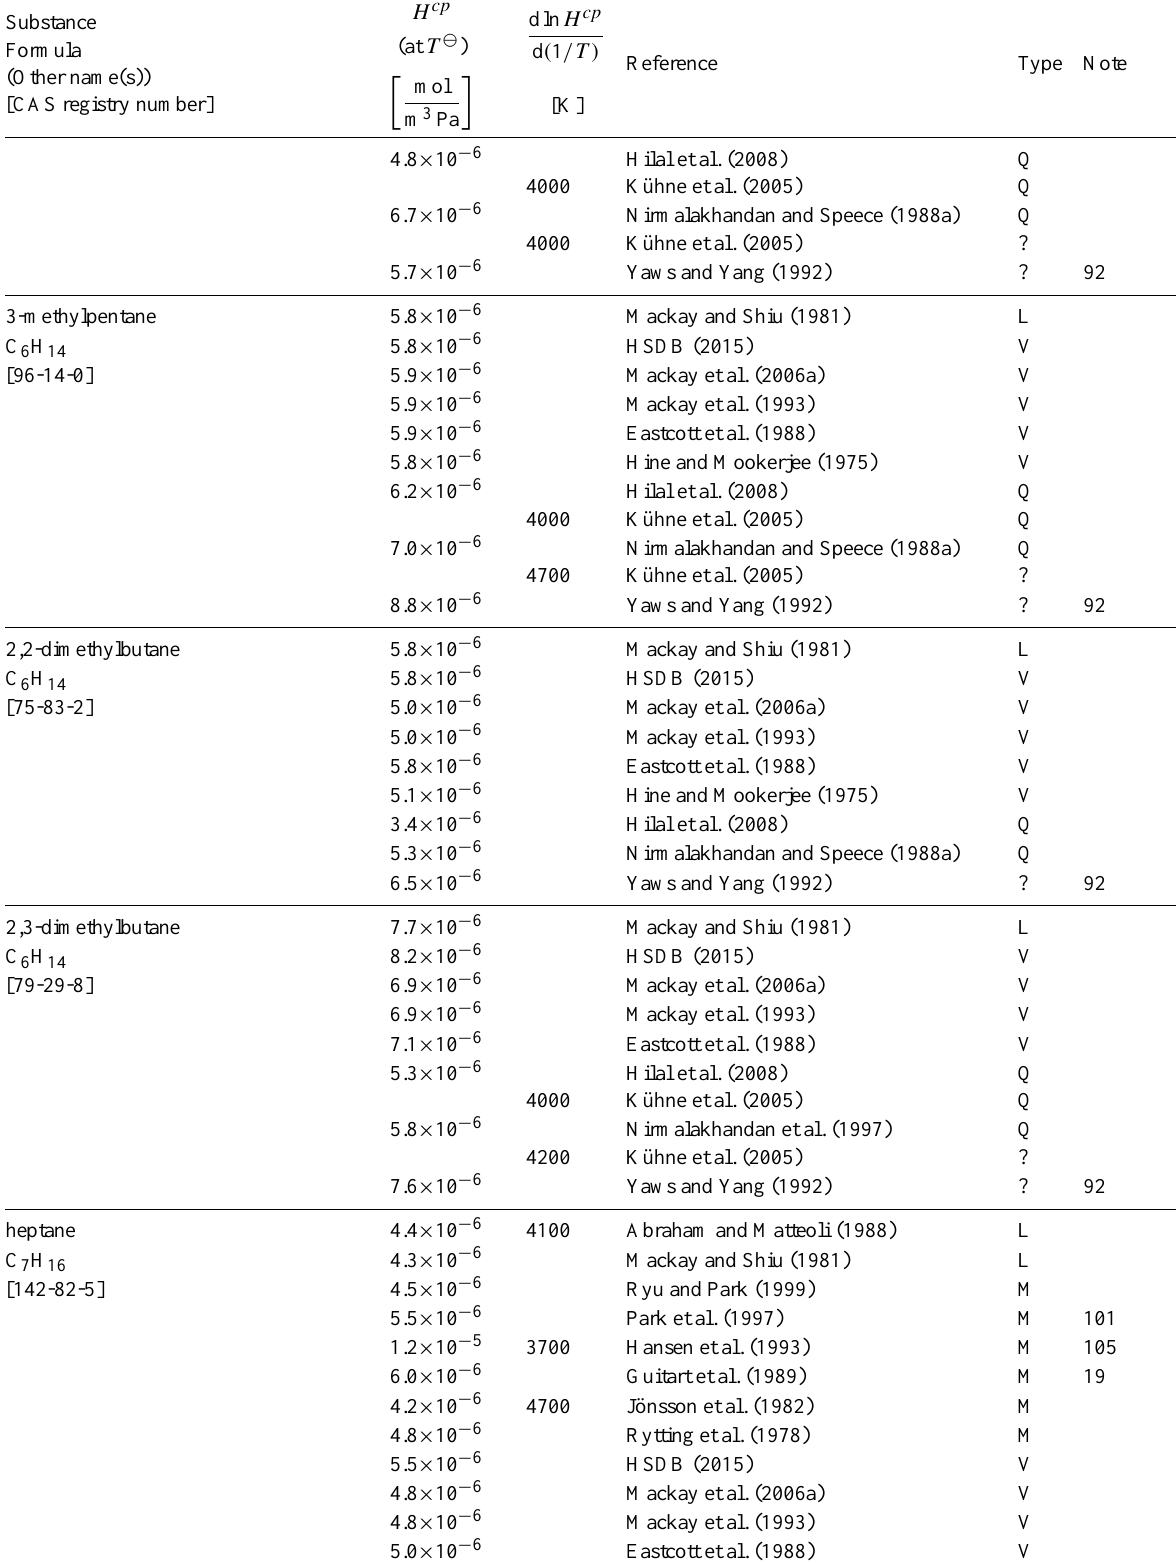
Table 6: Henry’s law constants for water as solvent